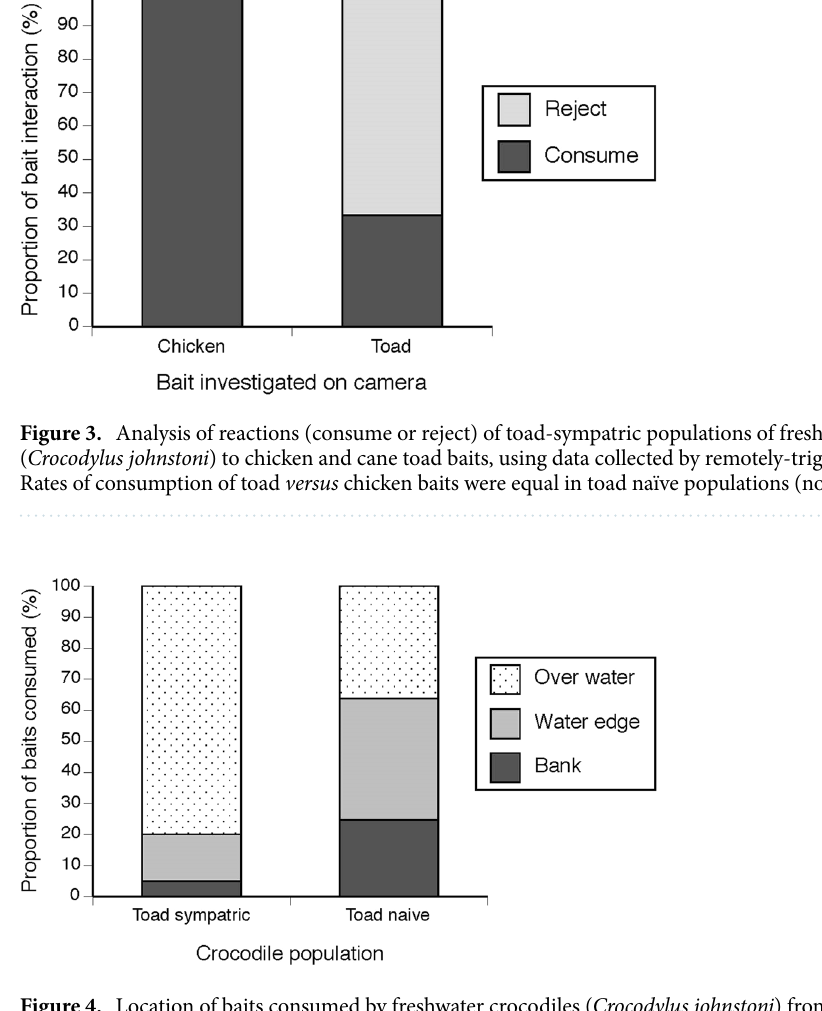
Figure 4. Location of baits consumed by freshwater crocodiles ( Crocodylus johnstoni ) from toad-sympatric and toad-naïve